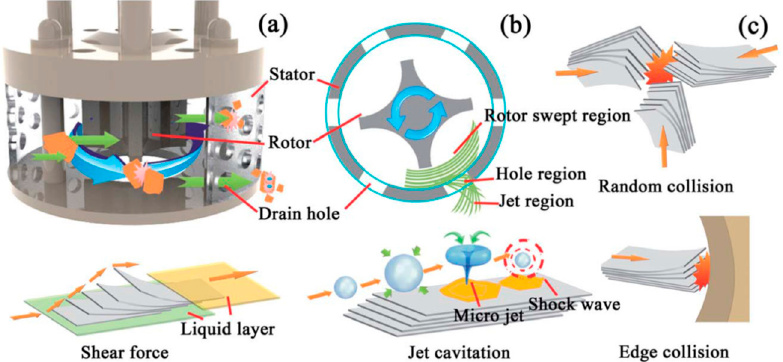
Figure 31. FJ300-S model high-shear mixer and mixer operation. Reproduced from [53]. Copyright IOP Publishing, 2017.